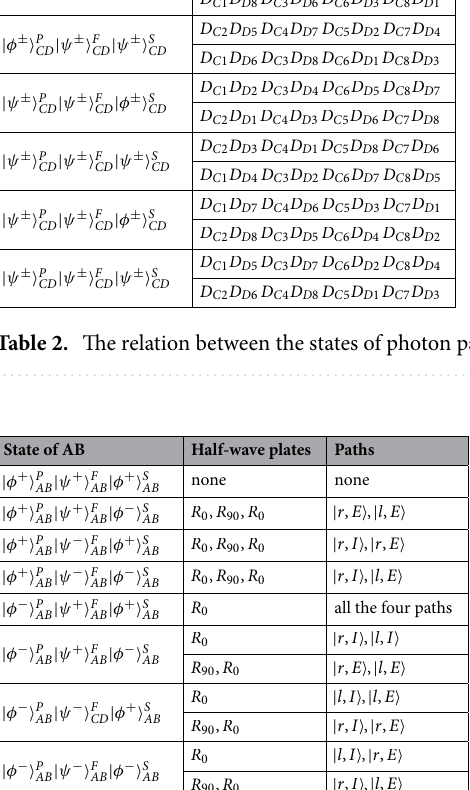
l , I r , E and , R 90 , R 0 in | � | � ( 1 ) i